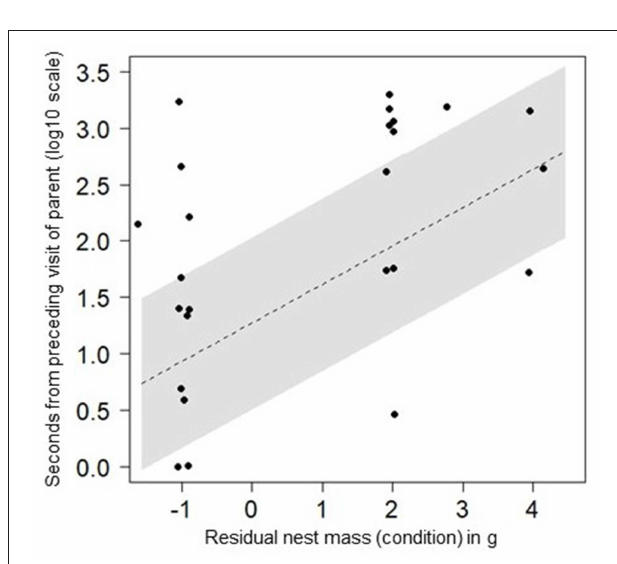
FIGURE 2 | How closely N = 9 fledglings followed their parents to supplementary feeders on N = 25 visits, depending on their condition as nestlings. Line of best fit and 95% confidence intervals are predicted from an LMM exploring effects of condition on follow timings, which included a random effect to account for repeated visits by some individuals (see Supplementary Table 2 ).